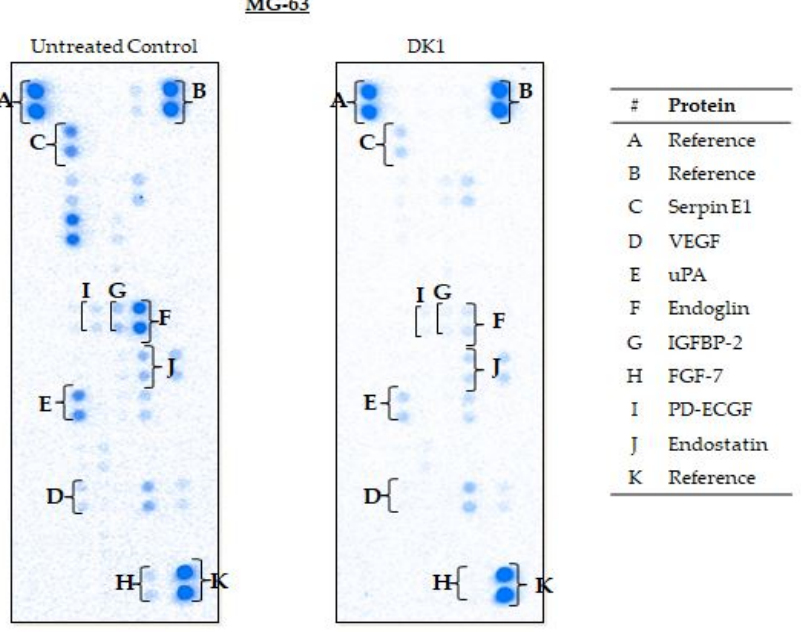
proteins between untreated control and curcumin analog DK1 in U-2 OS human osteosarcoma cell line.